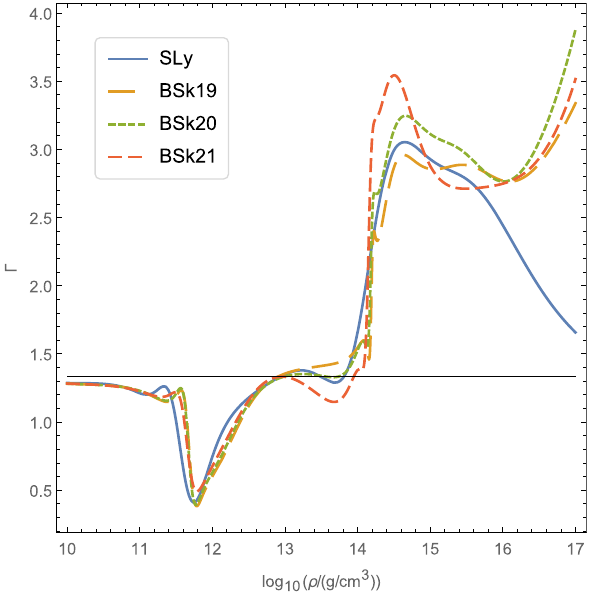
Fig. 2 The adiabatic index Γ for SLy and BSk EOSs. The horizon line marks Γ = 4 /